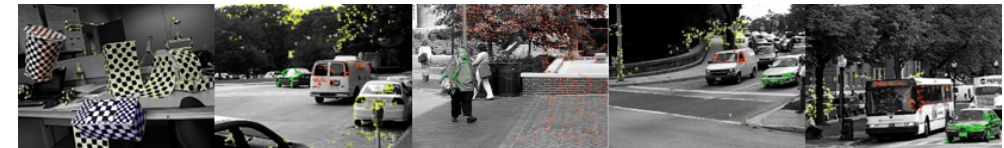
Figure 12. The typical images of the Hopkins155 motion segmentation database.